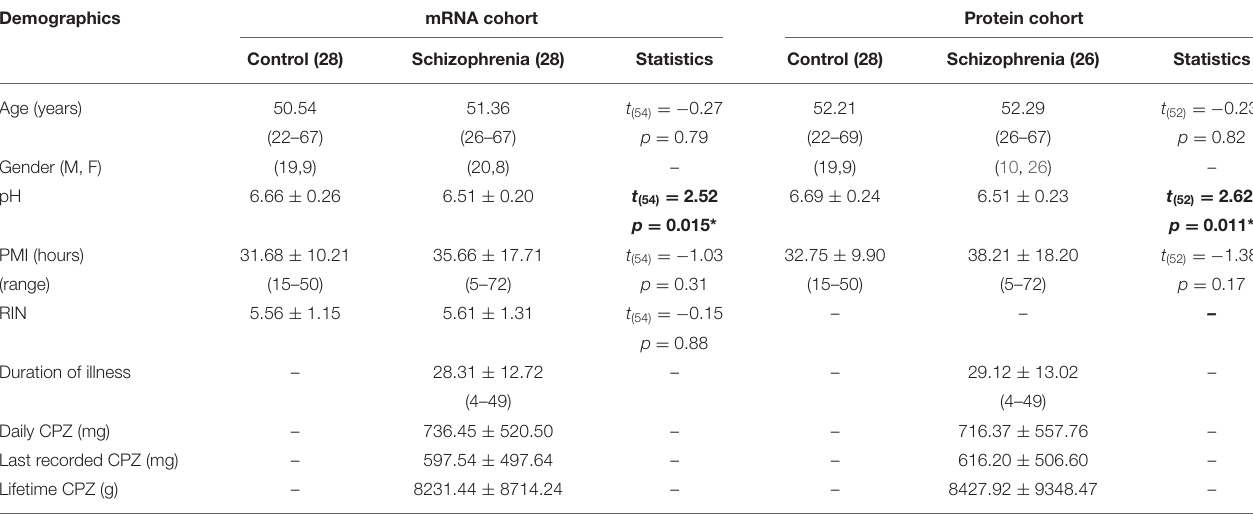
TABLE 1A | Demographic details of the postmortem midbrain mRNA and protein cohorts classified by